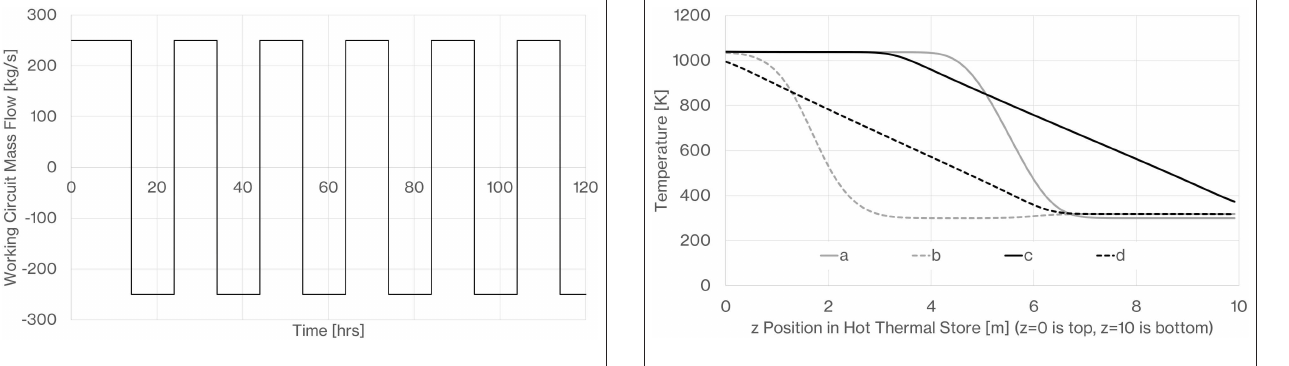
FIGURE 13 | Repeating charge/discharge cycle used. On the mass flow axis, + ve refers to charging, -ve refers to discharging.